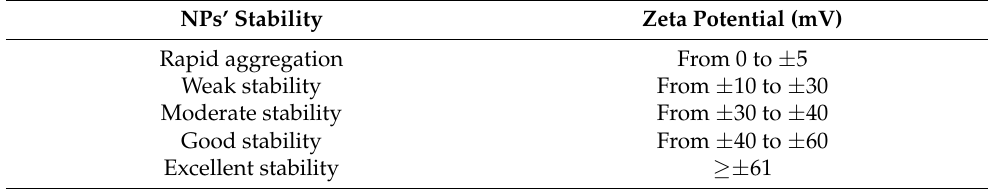
Table 1. Nanoparticles’ stability as a function of ζ -potential: reference values and